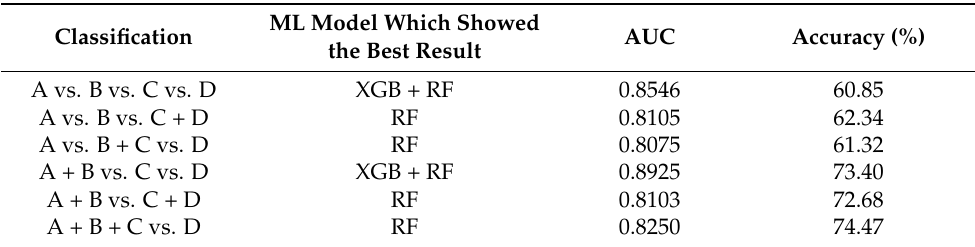
Table 3. Values of AUC and accuracy of machine learning analysis when comparing each group or their